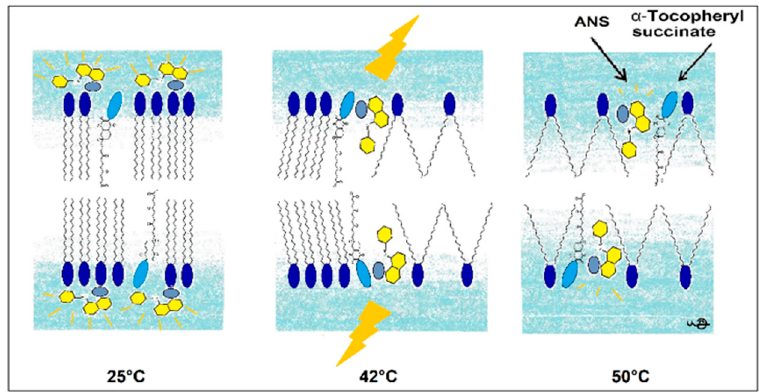
Figure 9. Pictorial presentation of structural changes in the DPPC membrane induced by TS reported by ANS fluorescence.